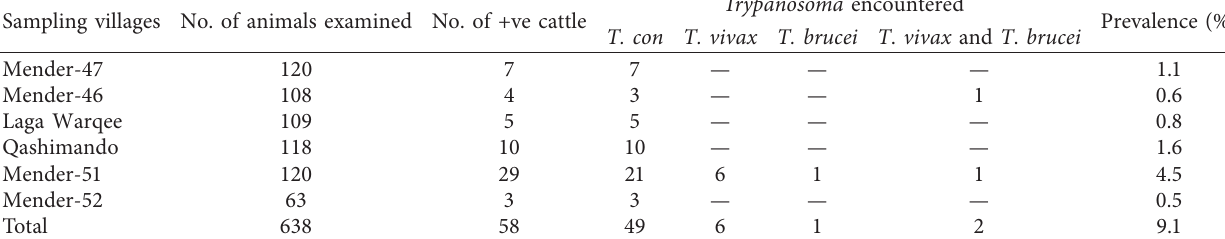
Table 3: Prevalence of cattle trypanosomosis and identified Trypanosoma species in the study area. Sampling villages No. of animals examined No. of +ve cattle